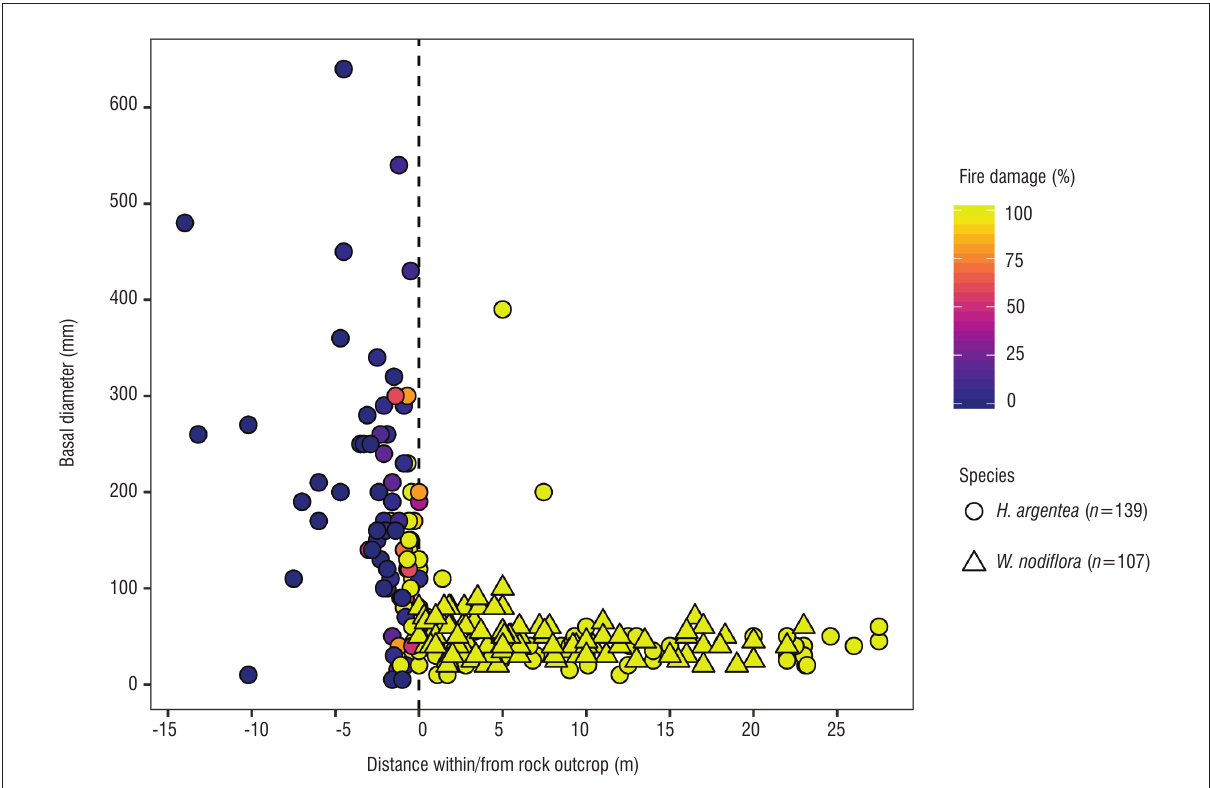
Figure 3: The proportion of canopy damage from a recent fire to Heeria argentea and Widdringtonia nodiflora trees of different sizes within (negative) and from (positive) rock